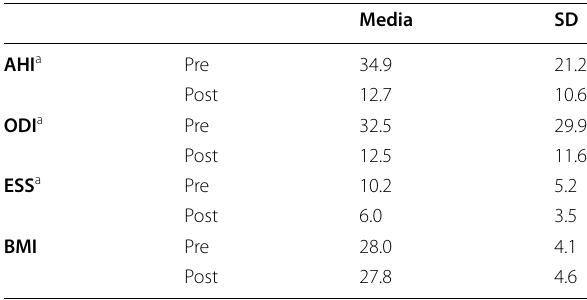
Table 4 Barbed sutures pharyngoplasty results in